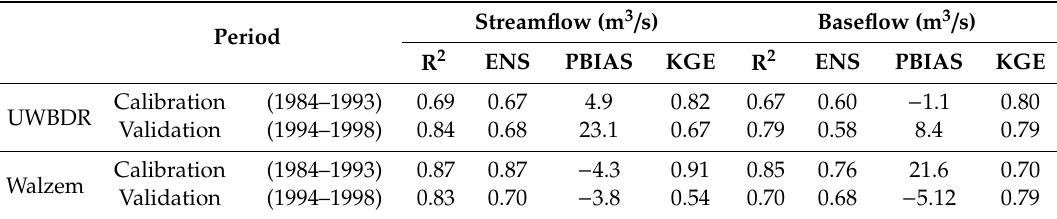
Figure 7. Observed and simulated time series streamflow for the UWBDR watershed during calibration and validation periods. Table 8. Statistical indicators for calibration and validation periods for streamflow and baseflow in the UWBDR watershed and Walzem Creek